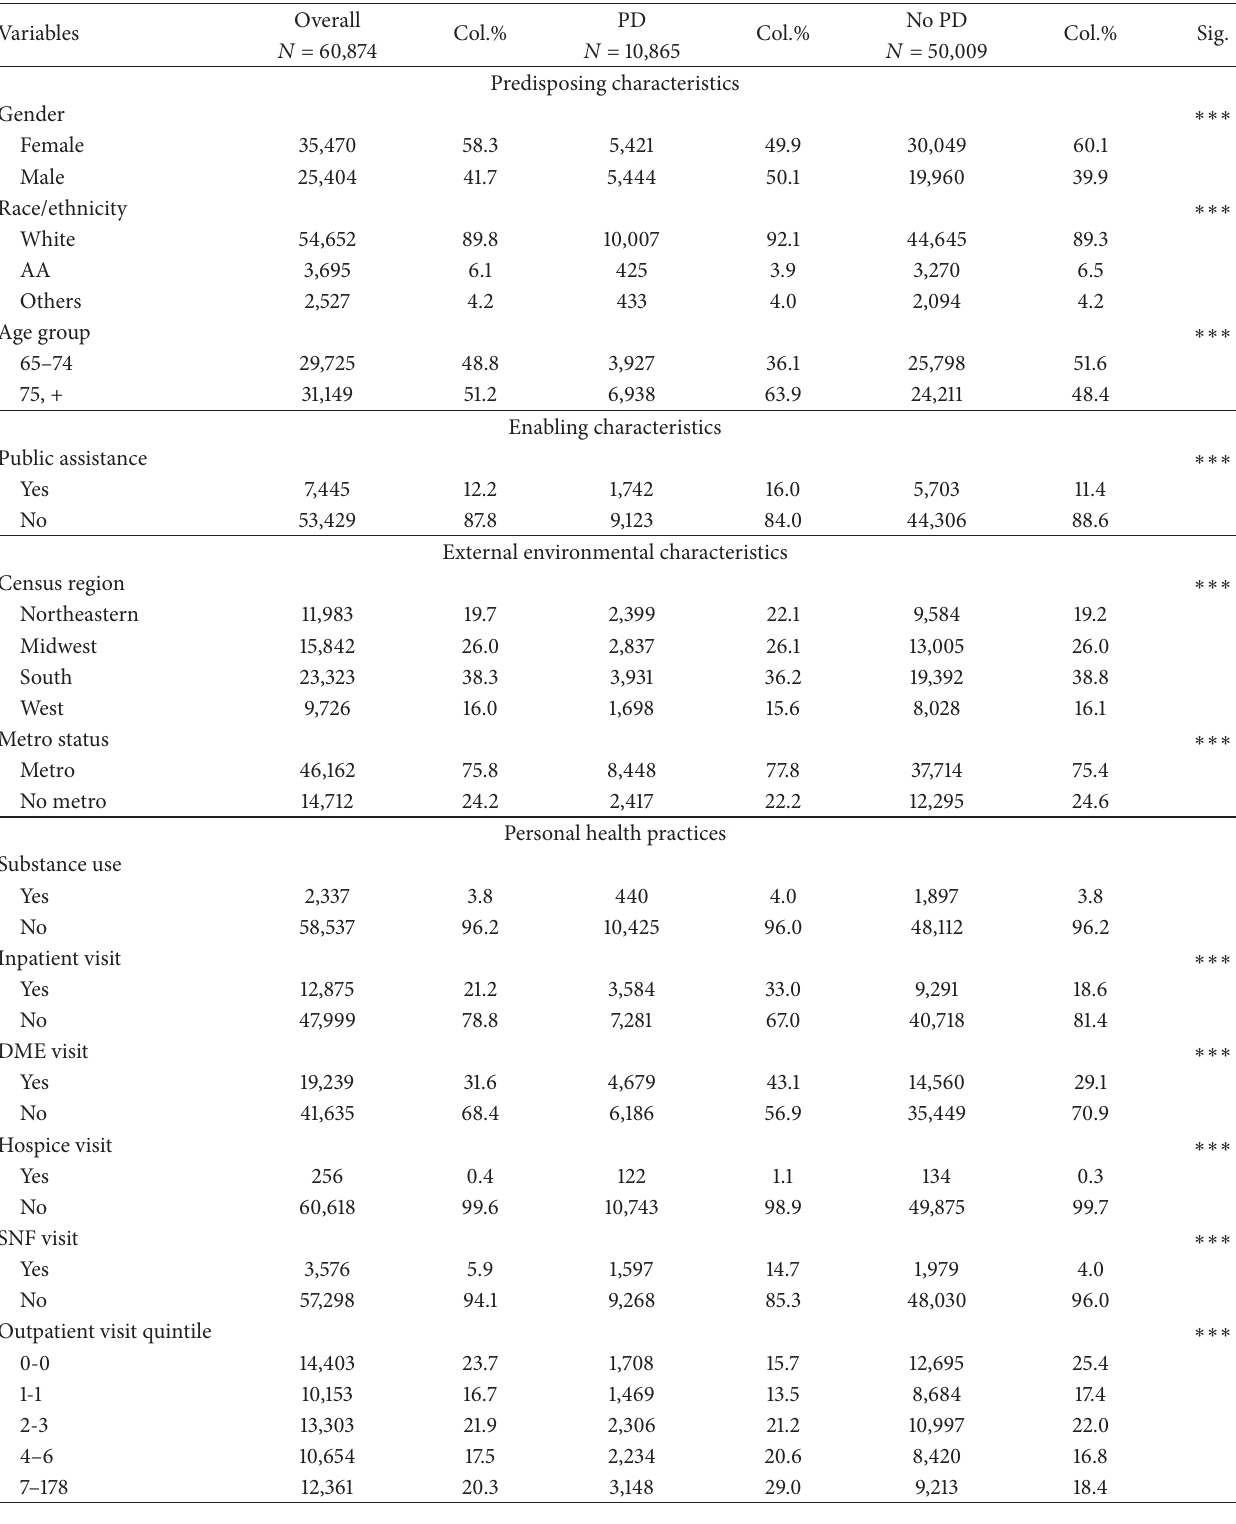
Table 1: Description of study sample, overall and by Parkinson’s disease status among Medicare beneficiaries. National Medicare 5% sample,